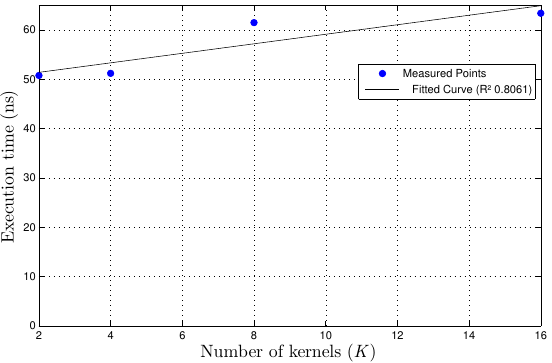
Figure 13. Linear regression curve for execution time per sample for varing numbers of kernels k , XOR dataset fixed-point